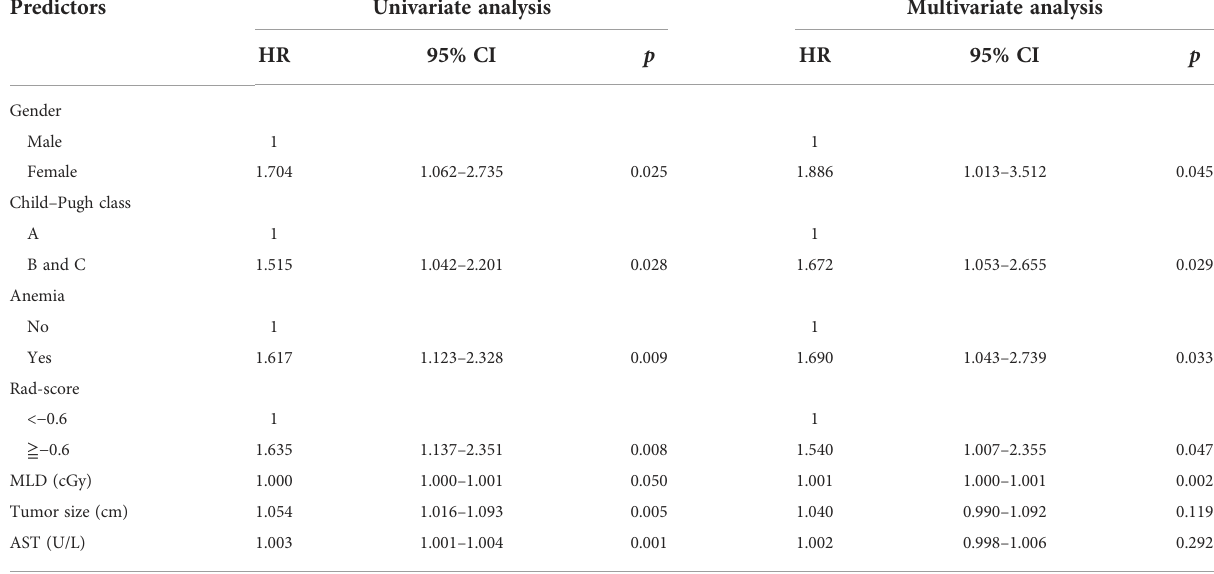
TABLE 7 Univariate and multivariate analyses for predictors of OS.